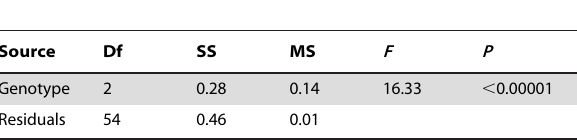
Table 5. ANOVA table of change of genotypic frequency per year within year